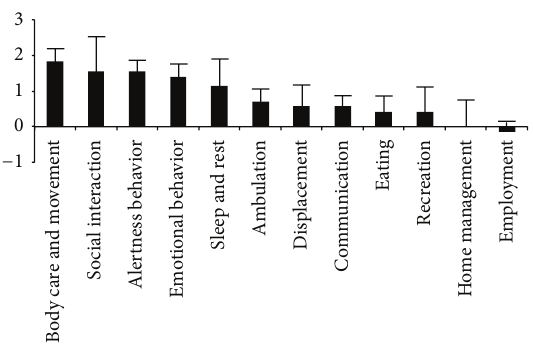
Figure 8: Improvement of subscores for each SIP category ( ± SEM). Positive values indicate improvement in quality of life. The largest improvements are observed for body care and movement, social interactions, alertness behavior, and emotional behavior. Each column represents the mean differential value between the pre- and postintervention measures (whiskers represent standard error of the